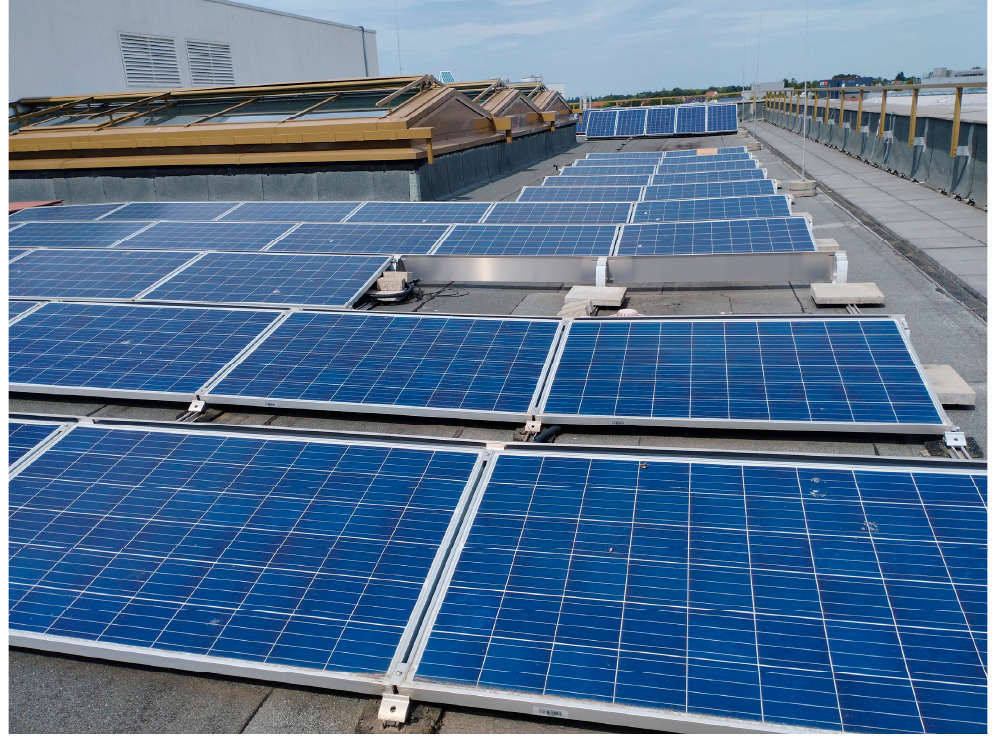
Figure 2. Smart PV system.